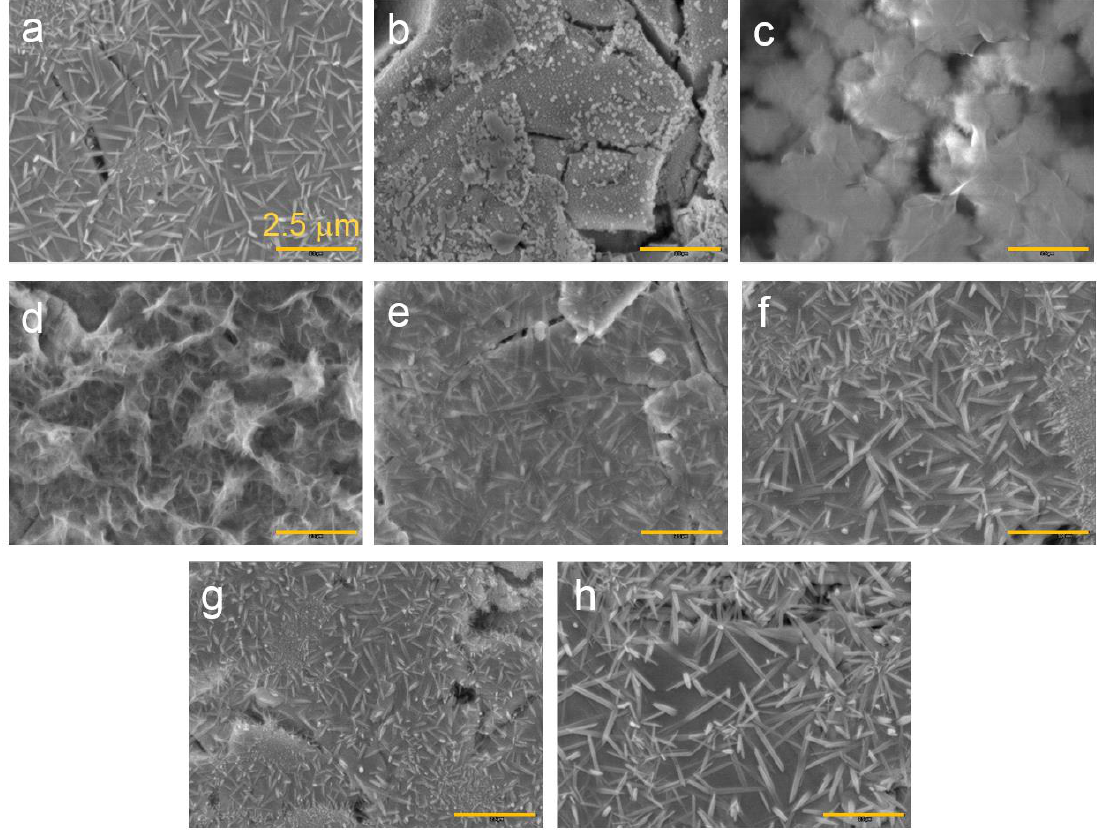
Figure 8. Scanning electron microscopy (SEM) micrographs from the etched alloys ( a ) A , ( b ) B , ( c ) C , ( d ) D , ( e ) E , ( f ) F , ( g ) G and ( h ) H . The bar at the lower right corner in each micrograph represents 2.5 µ m. Table 3. Measurement of weight change before and after KOH-etch for A and B . All numbers are in